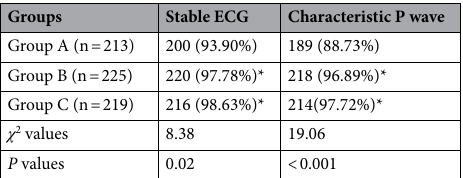
Table 2. The derived rate of stable intracavitary ECG and occurrence rate of characteristic P wave in the three groups [n (%)]. *Indicates P < 0.05 as compared with group